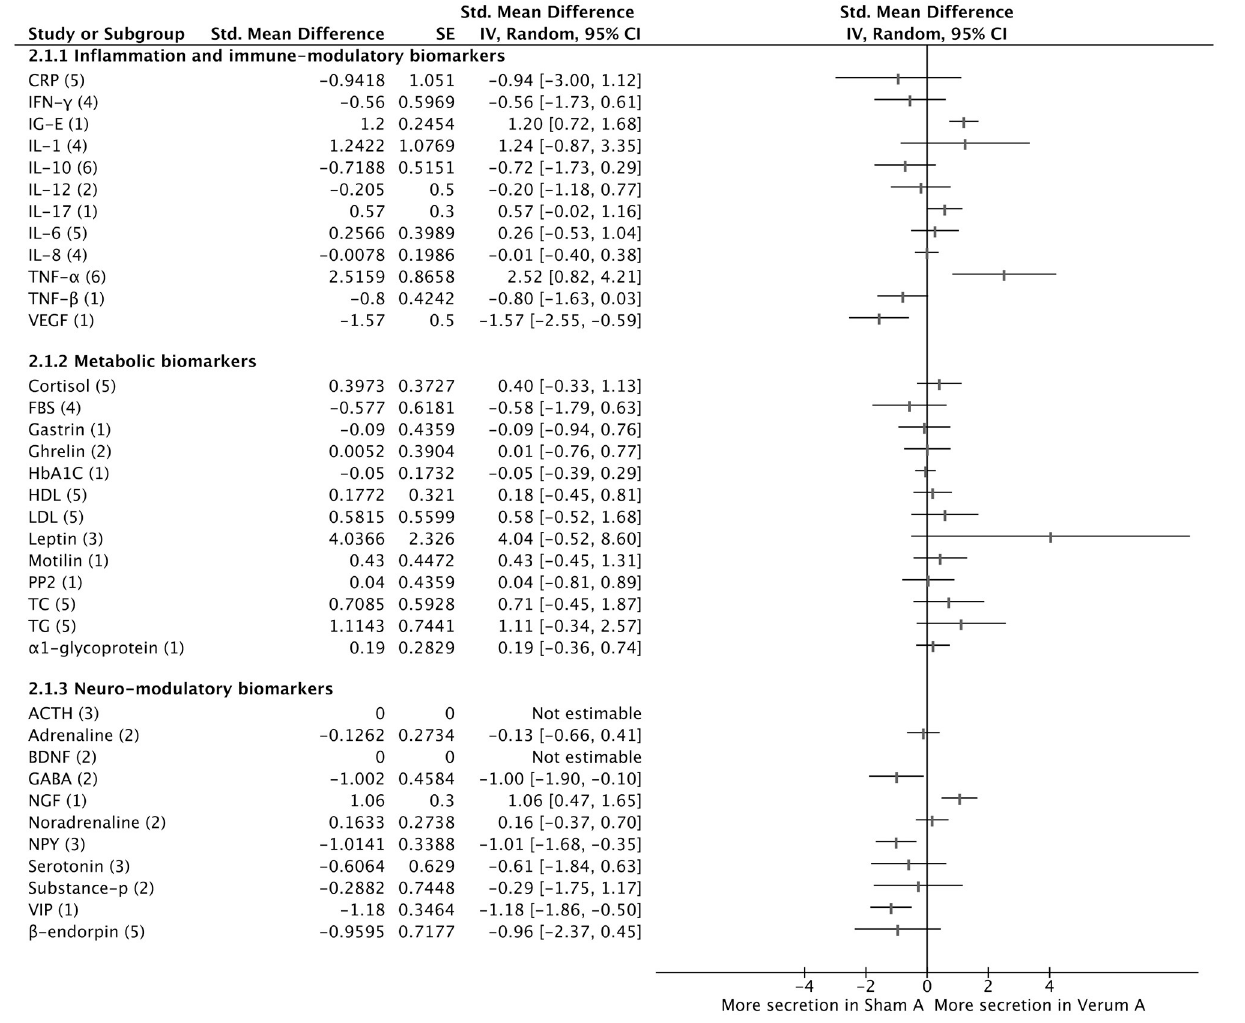
FIGURE 2 | Comparison of serum biomarkers secretion between sham acupuncture group and test acupuncture group. The number in parentheses indicates the number of studies included in the meta-analysis. BDNF, brain derived neurotrophic factor; CI, Confidence intervals; CRP, C-reactive protein; FBS, fasting blood glucose; GABA, γ -aminobutyric acid; HDL, high-density lipoprotein cholesterol; IFN- γ , Interferon gamma; IL, interleukin; LDL, low-density lipoprotein cholesterol; NGF, nerve growth factor; NPY, Neuropeptide Y; NR, not reported; PP2, 2-h postprandial blood glucose; SP, substance-P; Test A: TC, total cholesterol; TG, Triglycerides; TNF- α , tumor necrosis factor- α ; VIP, vasoactive intestinal peptide; Sham A, Sham acupuncture; Verum A, Verum